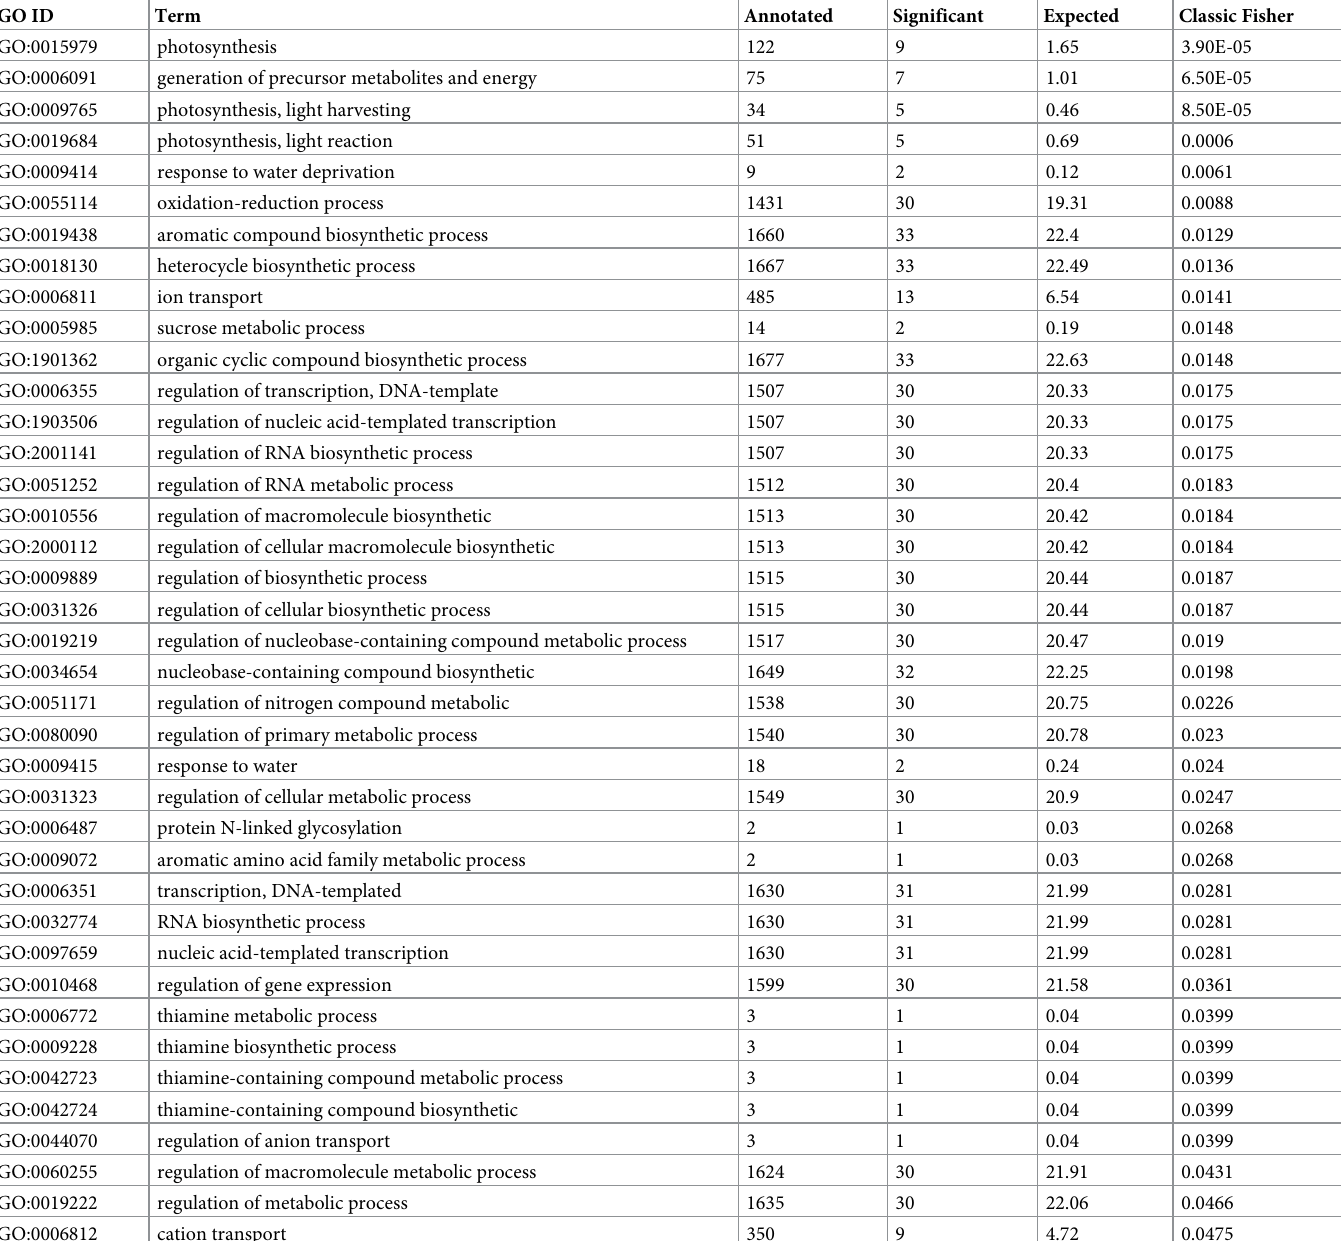
Table 1. Gene Ontology (GO) enrichment for the significantly upregulated co-expressed mRNAs of the neighboring